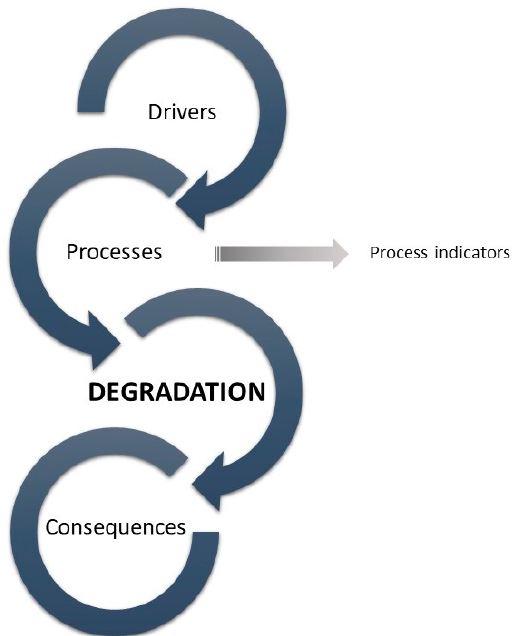
Figure1. Figure 1. Conceptual framework of drivers, processes, and consequences of natural grasslands degradation.